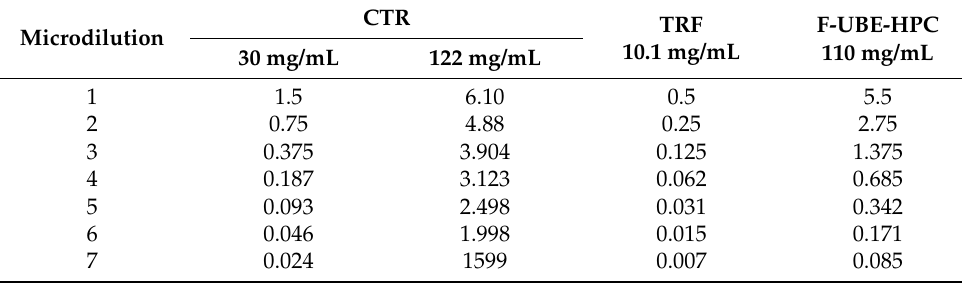
Table 4. Microdilutions of Ceftriaxone, Terbinafine, and F-UBE-HPC films. Microdilution